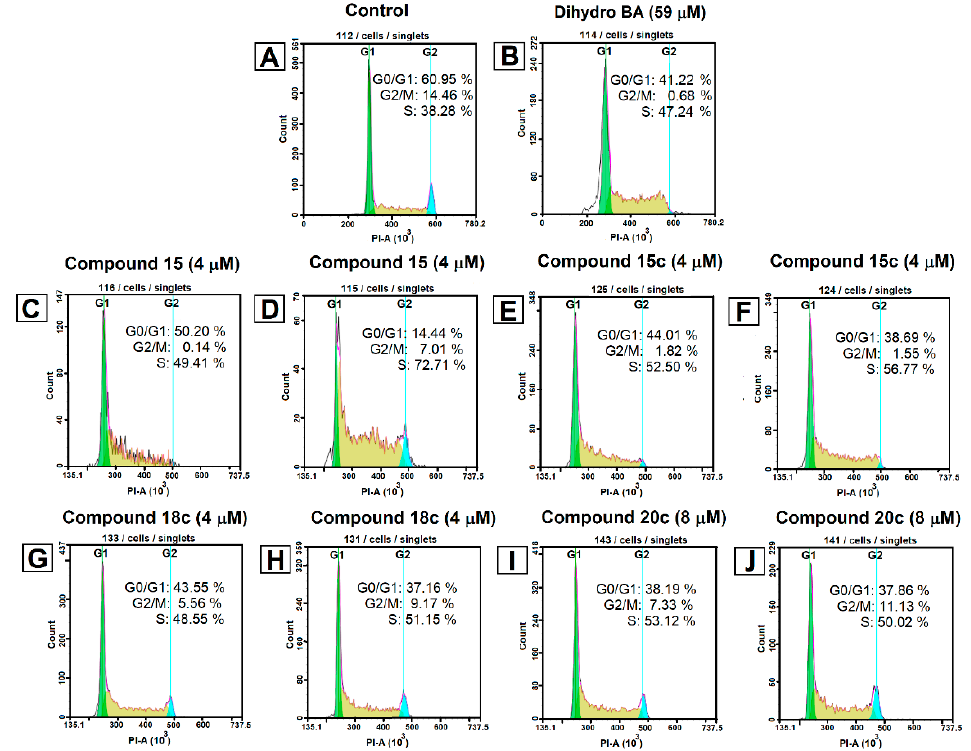
Figure 3. Cell cycle analysis in Jurkat cells. Jurkat cells treated with tested compounds at the IC 50 concentration for 24 and 48 h. The cells were trypsinized, harvested and washed three times with ice-PBS for PI-stained DNA content detected by flow cytometry. The experiments were performed three times, and the results of the representative experiments are shown. The first cytogram represents an untreated cell sample ( A ); after incubation with dihydrobetulinic acid for 48 h ( B ); after incubation with compound 15 for 24 h ( C ) and for 48 h ( D ); after incubation with compound 15c for 24 h ( E ) and for 48 h ( F ); after incubation with compound 18c for 24 h ( G ) and for 48 h ( H ); after incubation with compound 20c for 24 h ( I ) and for 48 h ( J ).